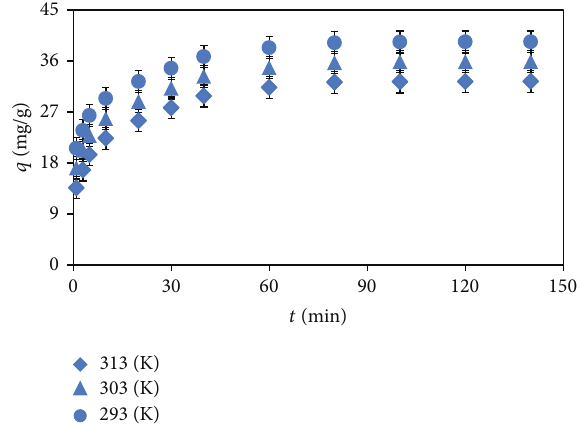
Figure 3: Effect of temperature and contact time (pH: 3, 𝑚 : 1gL −1 , 𝐶 : 100mgL −1 o